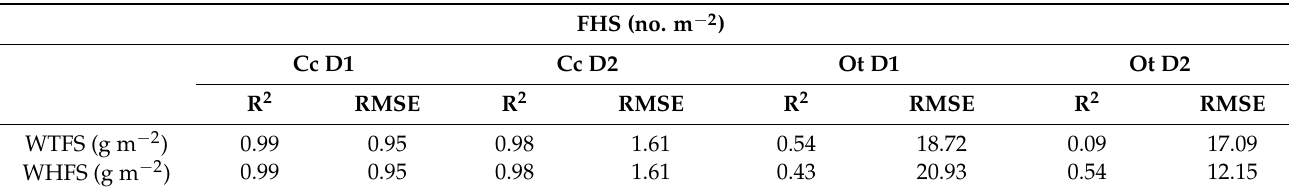
Table 10. Coefficient of determination and root mean square error (RMSE) of the linear relationship between the average of number of flower heads per square meter (FHS), weight of tubules and flower heads (WTFS) and weight of flower heads per square meter (WHFS) between the two compared plant